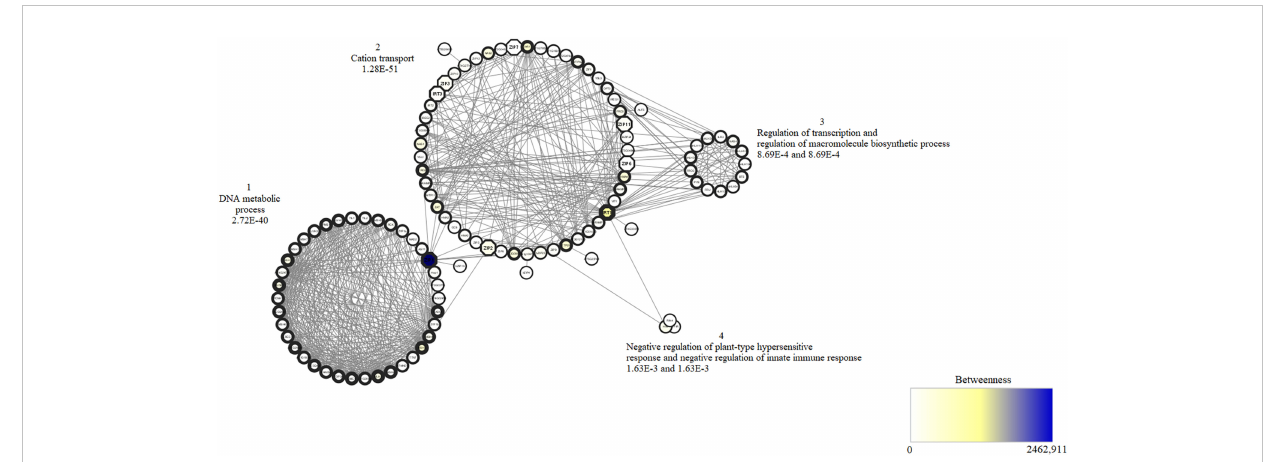
FIGURE 7 View of an interaction network of proteins from A. thaliana homologous to those identi fi ed in T. cacao . The betweenness value is represented by the color of the nodes; the lightest is the lowest value and the darkest is the highest value. This represents the node ’ s ability to join multiple clusters or groups of nodes. The edge width of nodes represents the node degree value, so the larger the edge width, the larger the value and vice-versa. The node degree property represents the number of connections that cross a single node. Clusters are subsets of nodes that are primarily connected to each other. For each cluster, a biological process with the lowest corrected value was assigned according to BiNGO